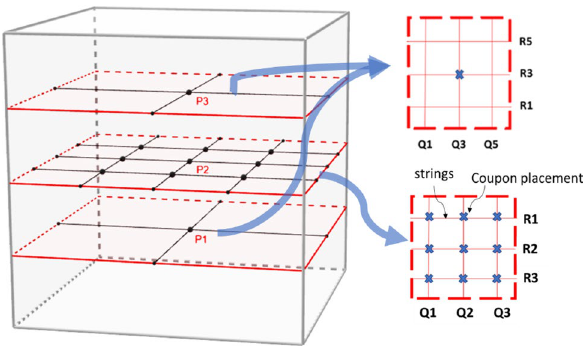
Figure 4. Measurement grid for decontamination measurement in three planes.